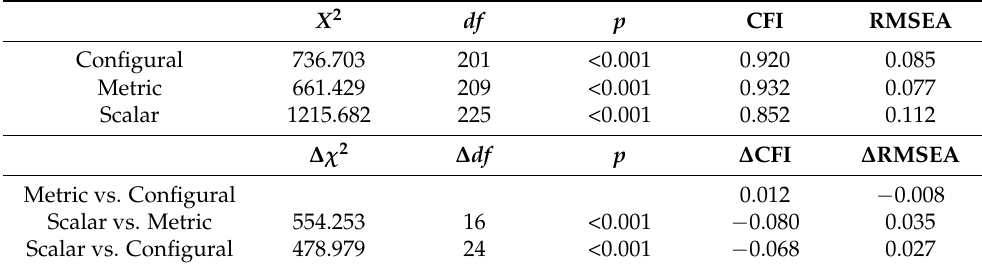
Table 1. Model Fit Indices and Model comparisons for MG-CFA.